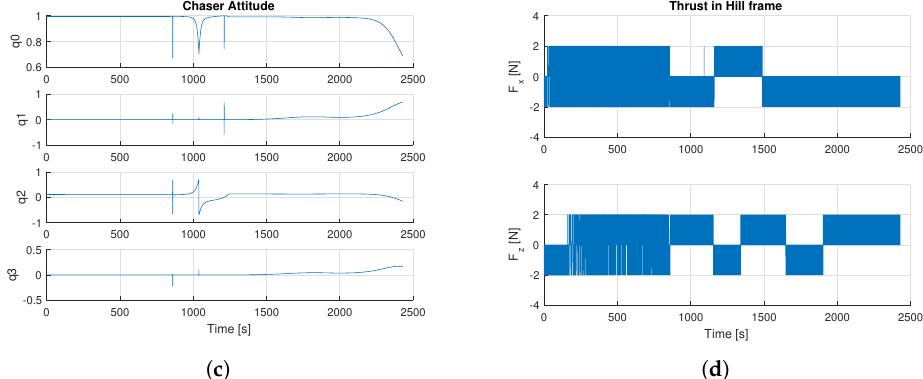
Figure 7. First maneuver highlights for the SMC controller (sliding mode controllers). ( a ) First Maneuver: V BAR − R BAR plane. ( b ) Relative velocity. ( c ) Relative quaternion. ( d ) Thrust profile.